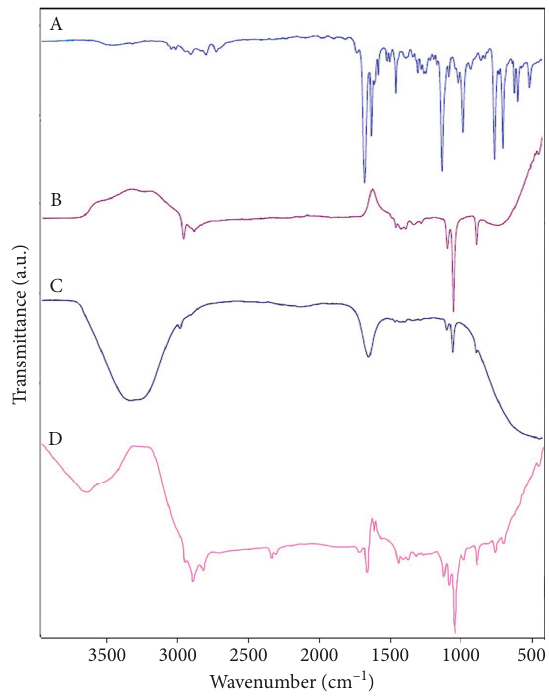
Figure 4: ATR-FTIR of A: C. zeylanicum EO, B: free liposomes, C: nanoliposomes containing the C. zeylanicum EO, and D: nano- liposomes gel containing the C. zeylanicum EO.